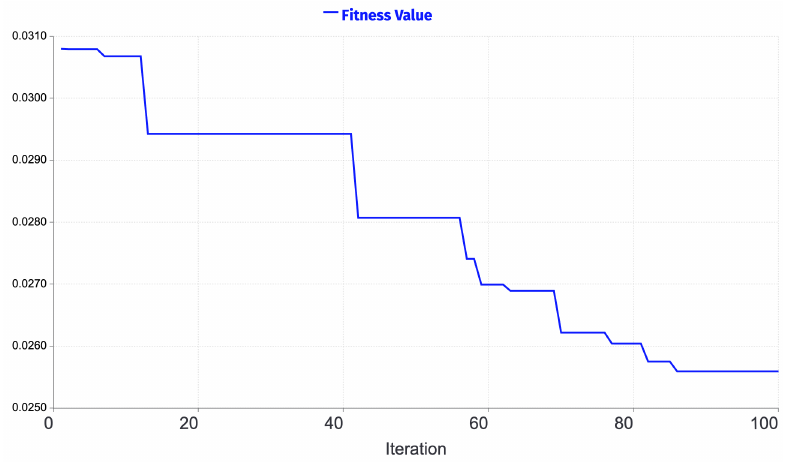
Figure A10. The training convergence curve when using the ANN with the CSO and the MSE fitness function for the dataset of Taiwanese companies.